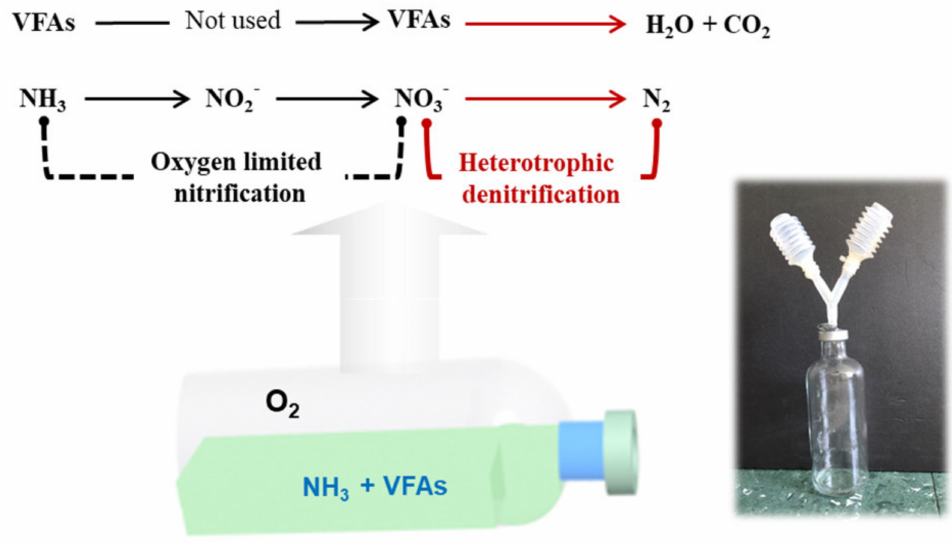
Figure 1. Simultaneous nitrification and denitrification system. Flow of nitrogen removal and target analysis in each step, with repeated cycles. Biomass sample was taken from the highest COD/N ratio bottle. The inserted photo is a reactor used in the experiment connected with spring tubes designed in consideration of the reaction that creates negative pressure (4NH 3 + 8O 2 + 5C → 2N 2 + H 2 O + 5H + + 5HCO 3 −